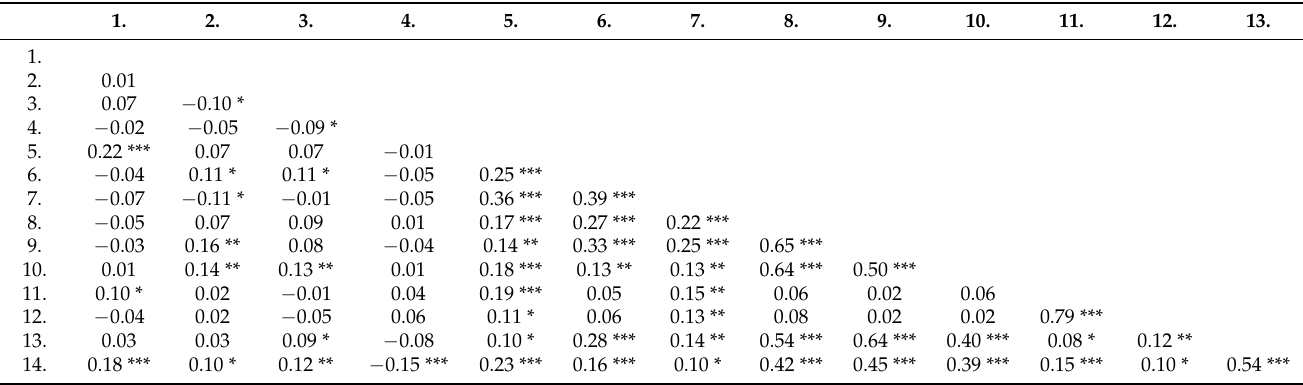
Table 2. Point biserial correlations among the variables of this